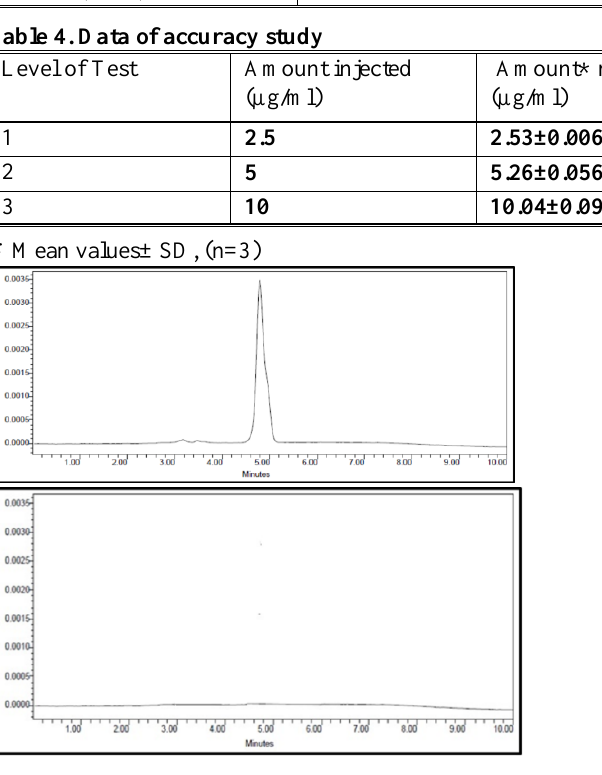
Table 4. Data of accuracy study